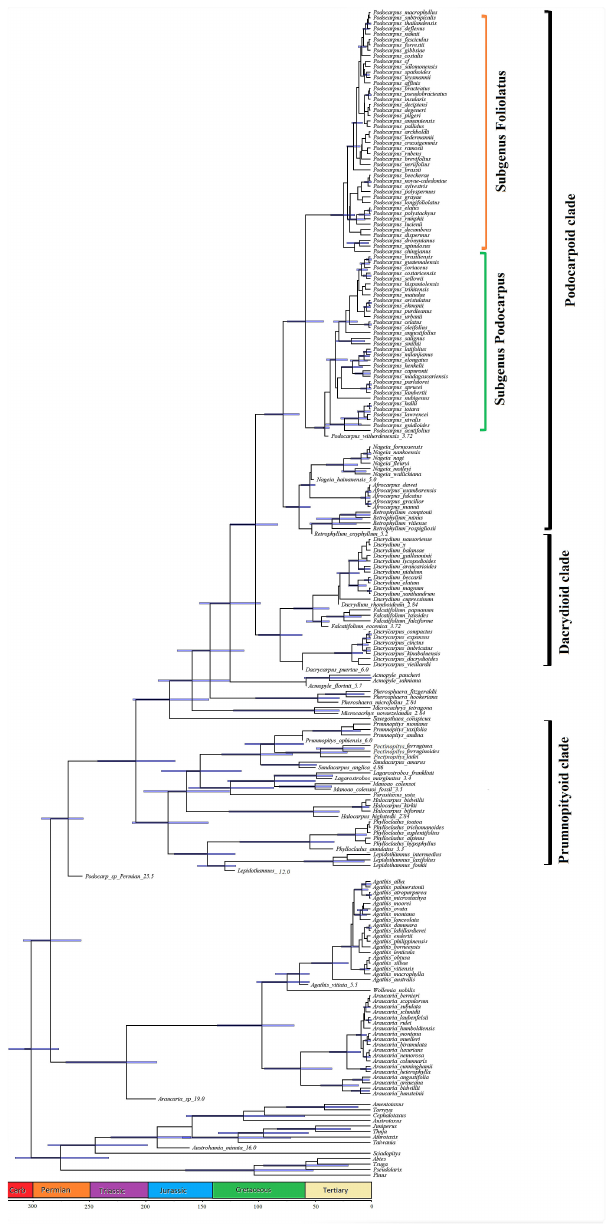
Figure 1. The phylogenetic relationships and divergence time of the 20 extant podocarp genera within Podocarpaceae. Blue node bars indicate the 95% highest posterior density divergence time estimates for the corresponding node. Branch lengths are proportional to time (Ma, millions of